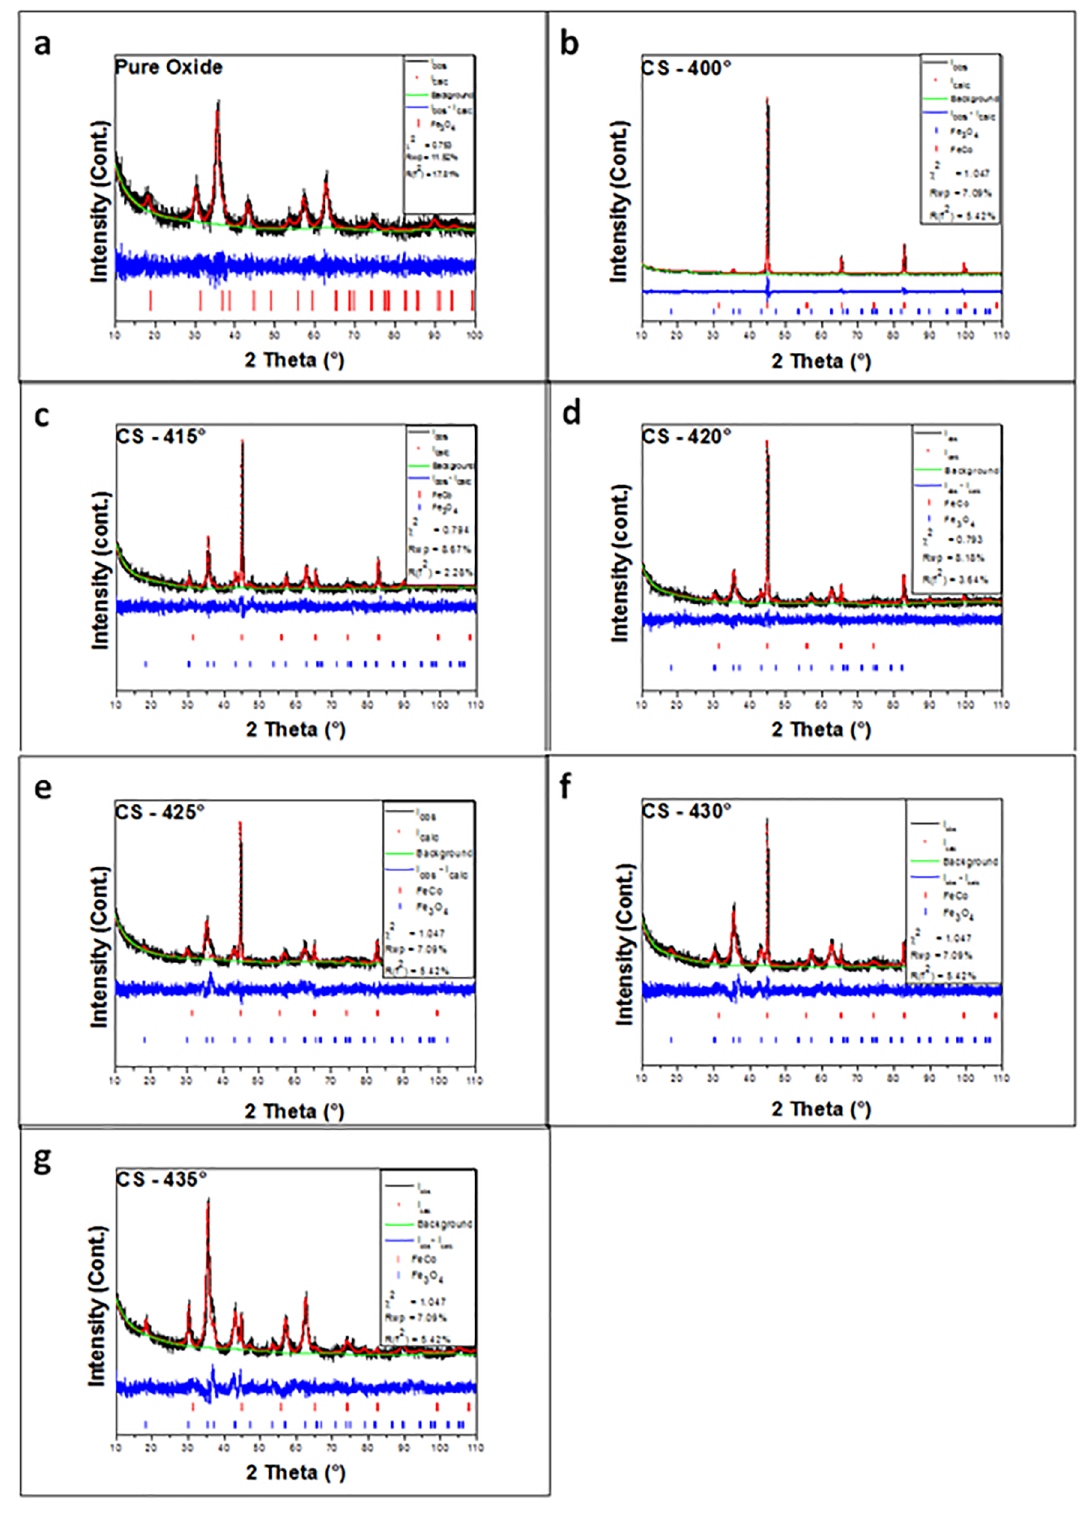
Figure 3. X-ray diffraction (XRD) and refinement by the Rietveld method of the sample: a) Pure oxide. b) CS-400. c) CS-415. d) CS- 420. e) CS-425. f) CS-430. g)